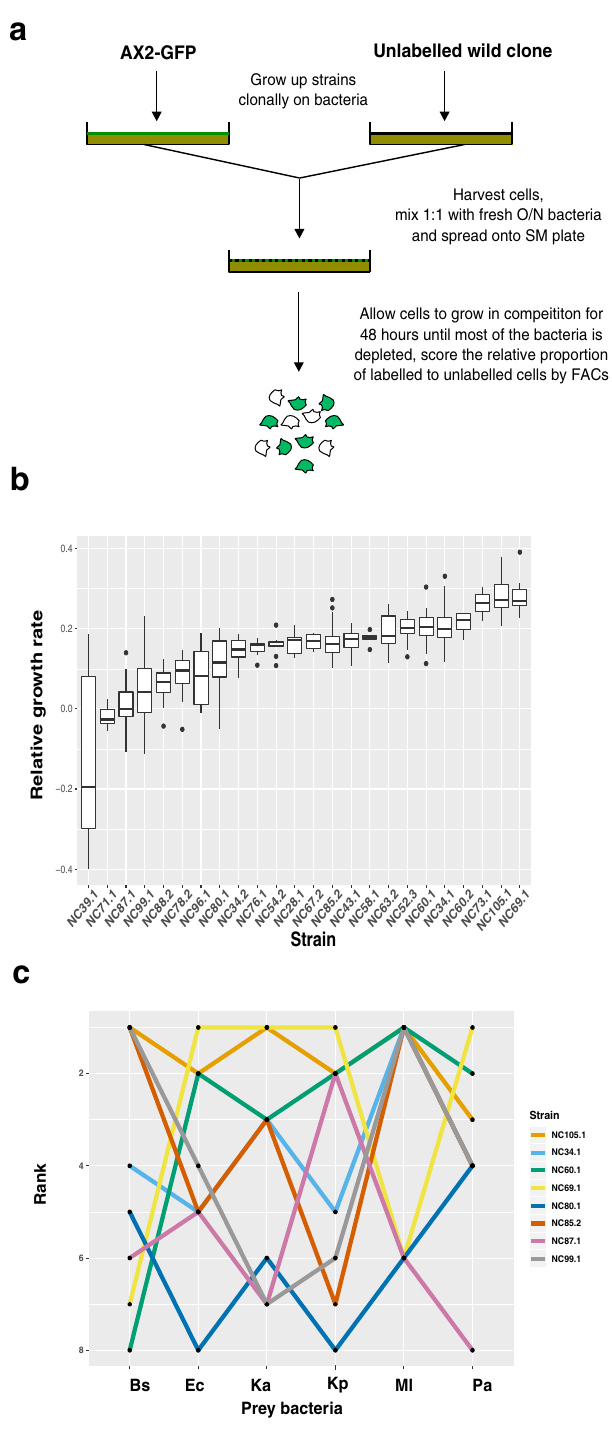
association with D. discoideum isolated from different environments 35 and is widely used for routine D. discoideum culture. The growth of each strain over 48 h (about 10 genera- tions) was measured in competition against a standard GFP- labelled laboratory strain (AX2-GFP), which was derived from the same location as our natural strains (Fig. 1a). The use of a standard competitor allowed for more sensitive detection of small differences in growth rate and the mitigation of block effects. We found that the 24 different strains show signi fi cant variation in their relative growth rates on K. aerogenes (one-way ANOVA